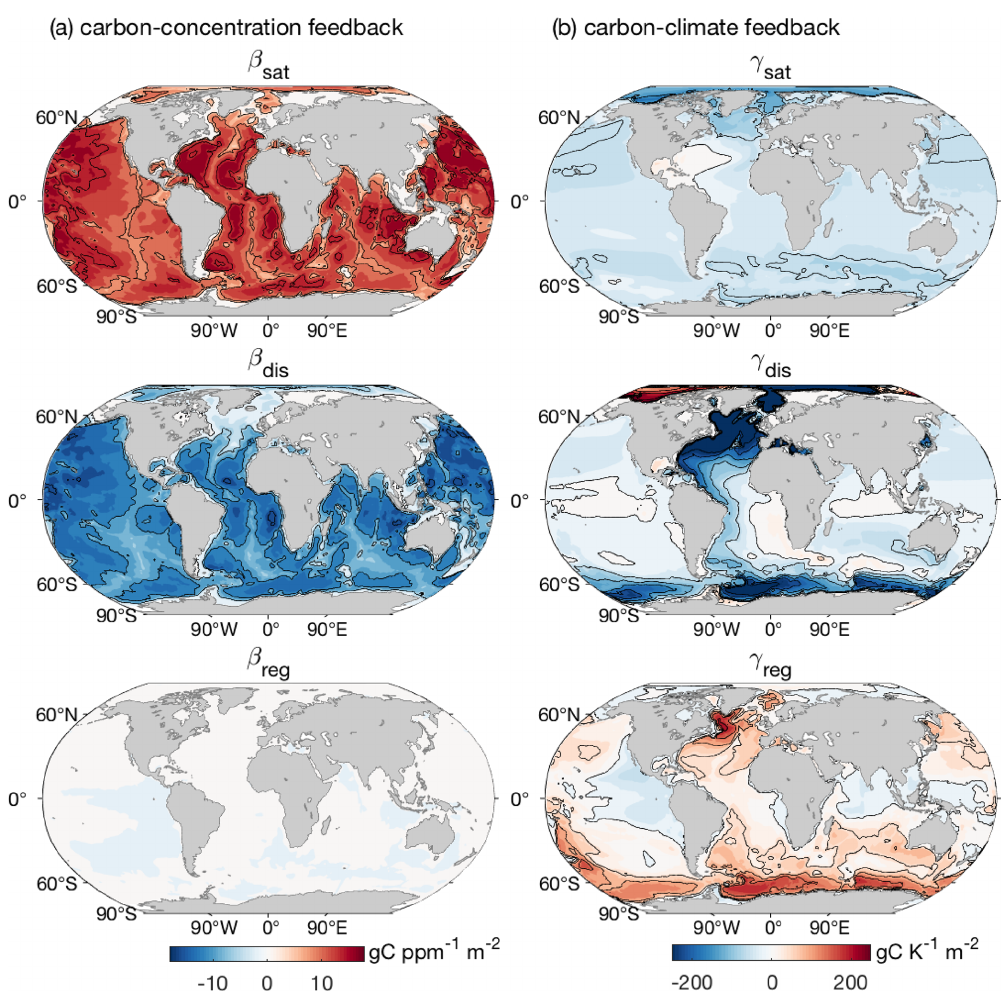
Figure B1. Geographical distribution of the CMIP6 inter-model mean contribution from the saturated, disequilibrium and regenerated car- bon pools to the carbon cycle feedback parameters estimated based on carbon storage, β ∗ and γ ∗ , normalised by area: (a) β sat , β dis and β reg (gCppm − 1 m − 2 ) and (b) γ sat , γ dis and γ reg (gCK − 1 m − 2 ). The estimates are based on the fully coupled simulation (COU) and